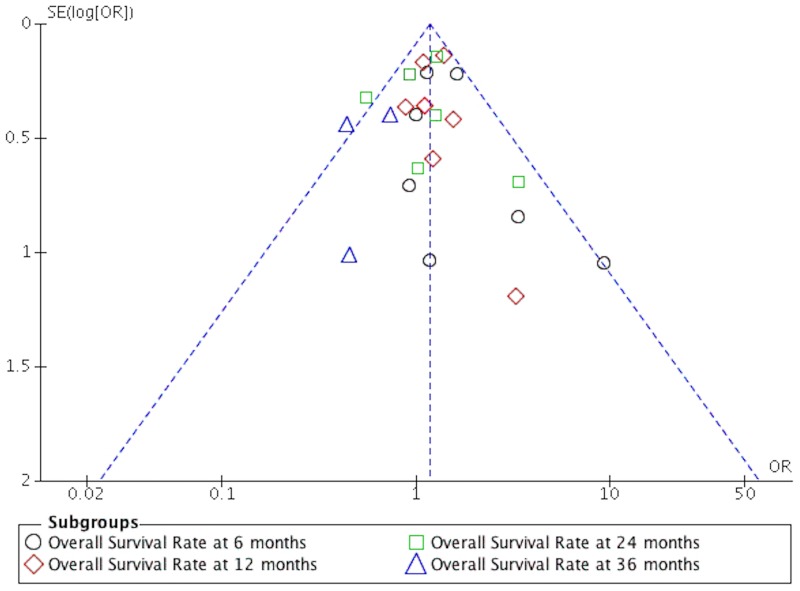
The funnel plot of OS on patients with newly diagnosed GB.